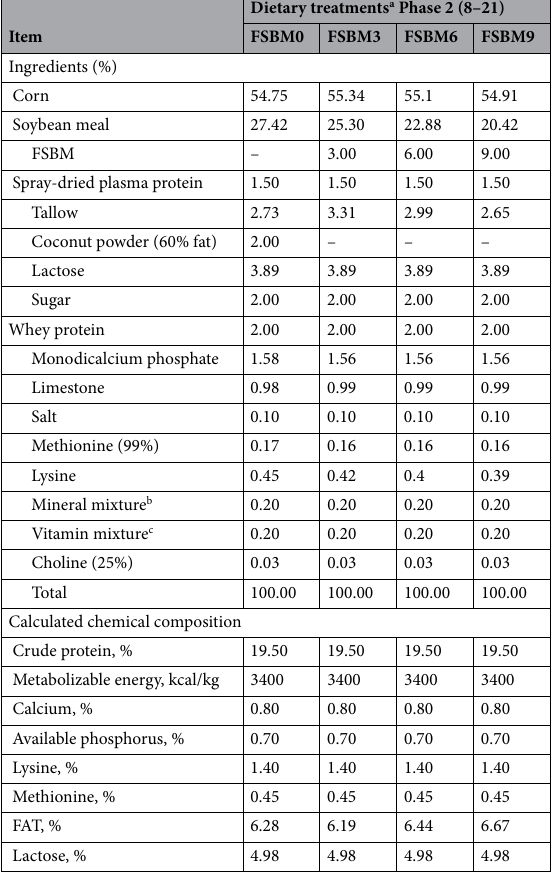
Table 3. Composition of weaning pig diets (as fed-basis). a FSBM0, FSBM3, FSBM6 and FSBM9 diets were made by substituting fermented soybean meal for 0, 3, 6 and 9% soybean meal. b Provided per kg diet: Fe, 100 mg as ferrous sulfate; Cu, 17 mg as copper sulfate; Mn, 17 mg as manganese oxide; I, 0.5 mg as potassium iodide; and Se, 0.3 mg as sodium selenite. c Provided per kilograms of diet: vitamin A, 10,800 IU; vitamin D3, 4000 IU; vitamin E, 40 IU; vitamin K3, 4 mg; vitamin B1, 6 mg; vitamin B2, 12 mg; vitamin B6, 6 mg; vitamin B12, 0.05 mg; biotin, 0.2 mg; folic acid, 2 mg; niacin, 50 mg; D-calcium pantothenate, 25